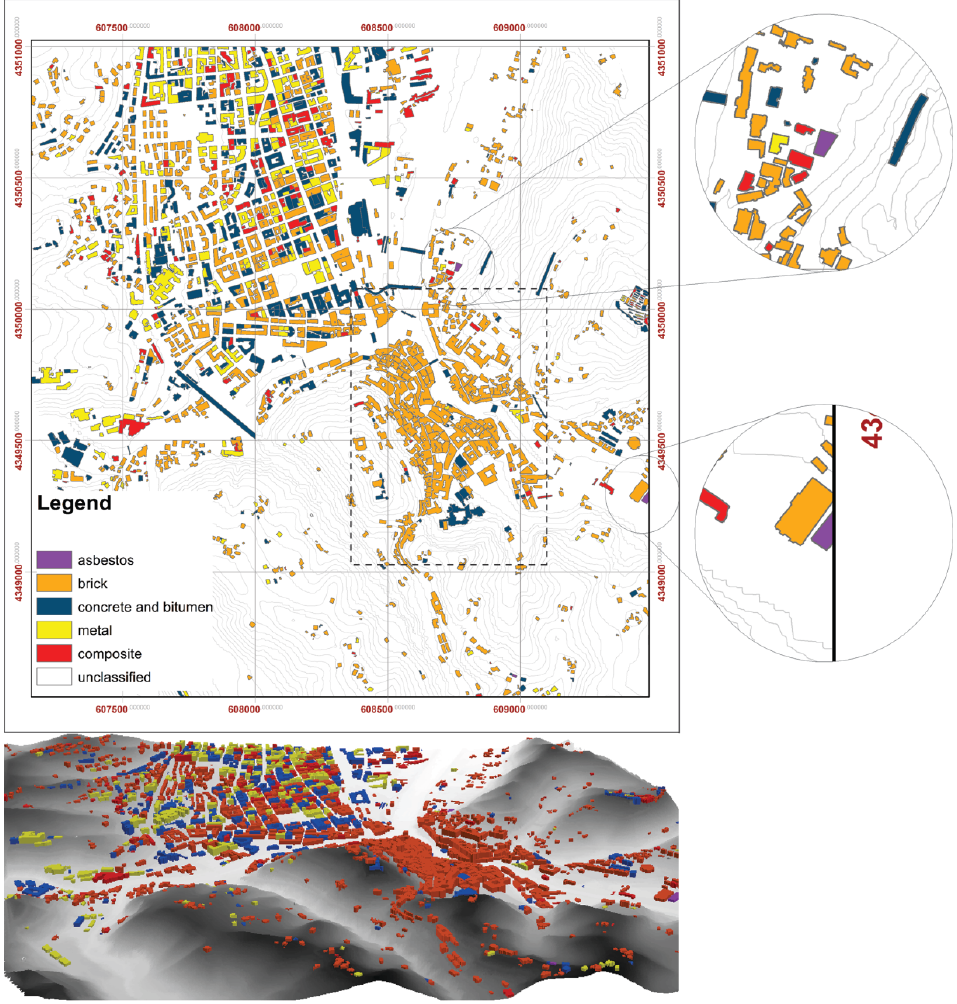
Figure 10. Classification of the buildings in the urban area of Cosenza based on the roof material: (upper panel) 2D map and (lower panel) 3D view.